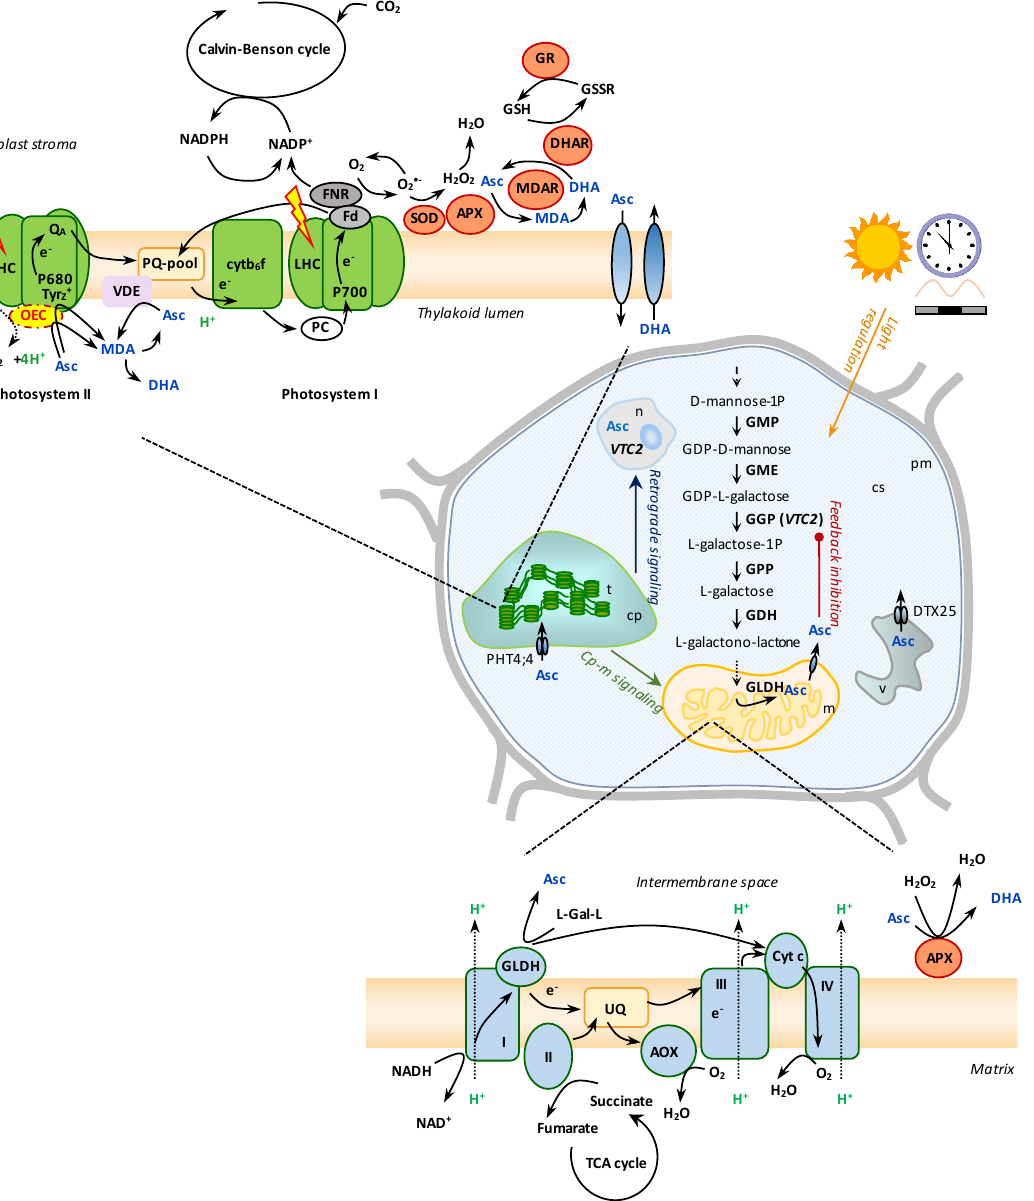
Figure 1. Ascorbate (Asc) biosynthesis and the roles of chloroplastic Asc in vascular plants. Asc is synthesized via the Smirnoff-Wheeler pathway with the majority of the steps taking place in the cytosol and the last step in the mitochondria at Complex I. Asc biosynthesis is regulated by light, circadian clock, photosynthetic electron transport, and a feedback inhibition by Asc. Asc is found in all cell compartments; PHT4;4 transports it into the chloroplast. Chloroplastic Asc plays multiple roles: (i) it is an alternative electron donor of photosystem II (PSII) when the oxygen-evolving complex (OEC) is inactive, (ii) it may inactivate the OEC under specific circumstances, (iii) it is a co- substrate of violaxanthin de-epoxidase (VDE) thereby plays a role in non-photochemical quenching, (iv) Asc participates in reactive oxygen species management. Abbreviations: APX, Asc peroxidase; cp, chloroplast; cs, cytosol; Cytb 6 f, cytochrome b 6 f; Cytc, cytochrome c; DHA, dehydroascorbate; DHAR, dehydroascorbate reductase; DTX25, vacuolar ascorbate transporter; Fd, ferredoxin; FNR, ferredoxin-NADP oxidoreductase; GDH, L-galactose dehydrogenase; GGP, GDP-L-galactose phos- phorylase (encoded by VTC2 ); GLDH, L-galactono-1,4 lactone dehydrogenase; GME, GDP-D-man- nose 3 ′ ,5 ′ -epimerase; GMP, GDP-D-mannose phosphorylase; GPP, L-galactose-1-P phosphatase; GR, glutathione reductase; L-Gal-L, L-galactono-lactone; LHC, Light-harvesting complex; m, mito- chondrion; MDA, monodehydroascorbate; MDAR Monodehydroascorbate reductase; n, nucleus; PHT4;4, chloroplastic Asc transporter; pm, plasma membrane; PSI, photosystem I; SOD, superoxide dismutase; t, thylakoid; TCA, tricarboxylic acid; UQ, ubiquitine; v, vacuole.